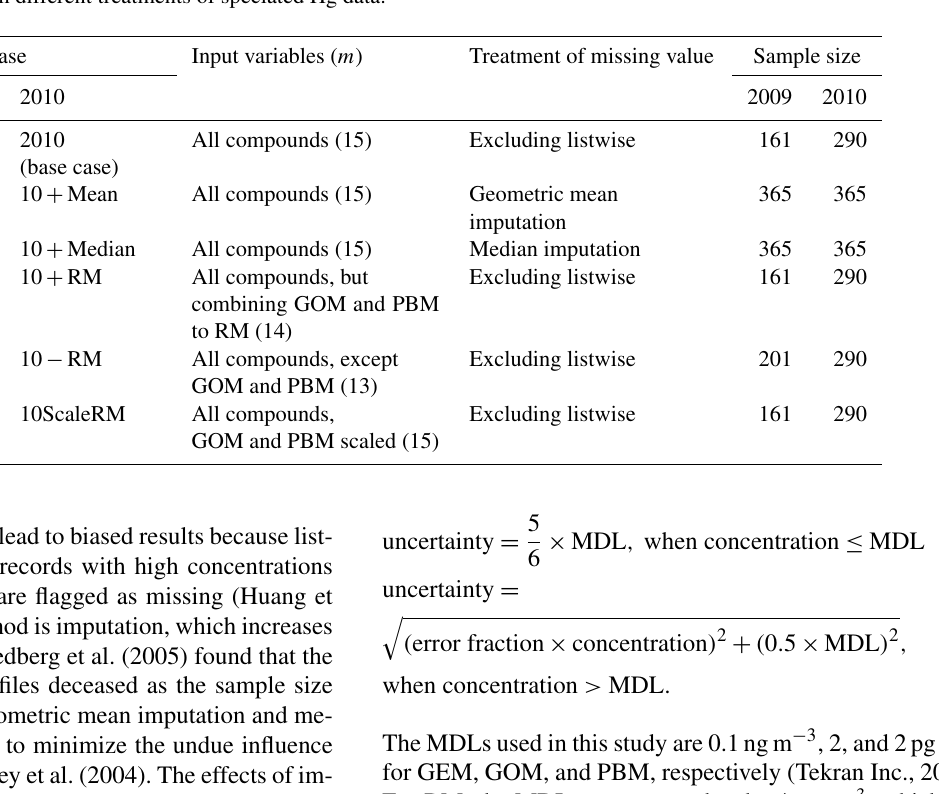
Table 3. PMF case design with different treatments of speciated Hg